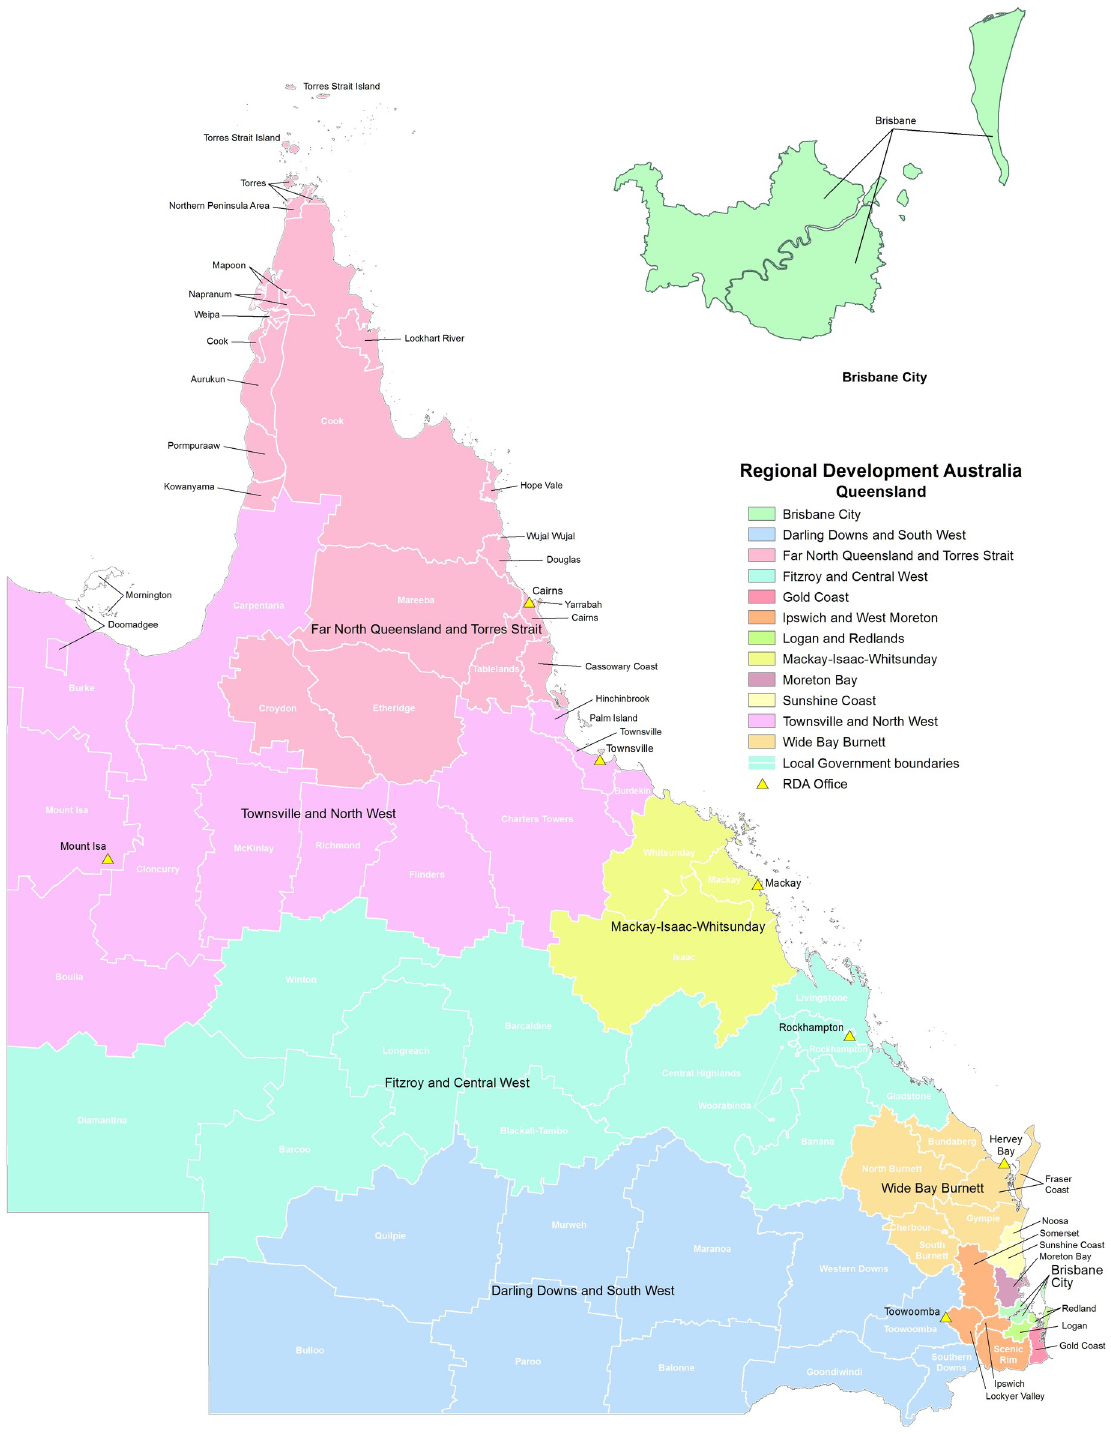
Fig 1. Location of FCW region in Queensland (Reprinted from Commonwealth of Australia Queensland RDA [27] under a CC BY license, with permission from RDA, original copyright 2019).